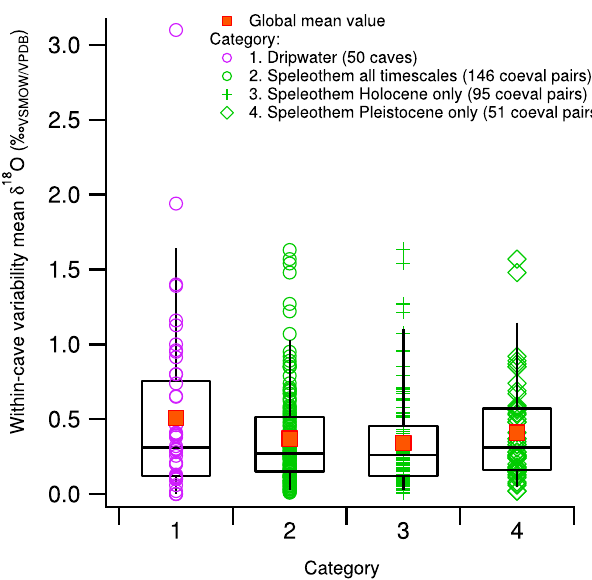
Fig. 2 Box and whisker plot comparing within-cave variability in dripwater and speleothem mean δ 18 O values. The analysis demonstrates that within-cave variability in speleothem mean δ 18 O values are comparable to the within-cave variability of dripwater mean δ 18 O values, inferring a fl owpath control. Category 1 (purple circles) are the range of dripwater mean δ 18 O values for each cave and category 2 (green circles) are speleothem Δδ 18 O means for each pair of coeval records. Speleothem Δδ 18 O means are divided into Holocene (category 3, green crosses) and Pleistocene epochs (category 4; green diamonds). Orange squares indicate the mean value, boxes indicate the inter-quartile range and whiskers the 5th and 95th percentiles. Data from the global meta-analysis of dripwater and speleothem